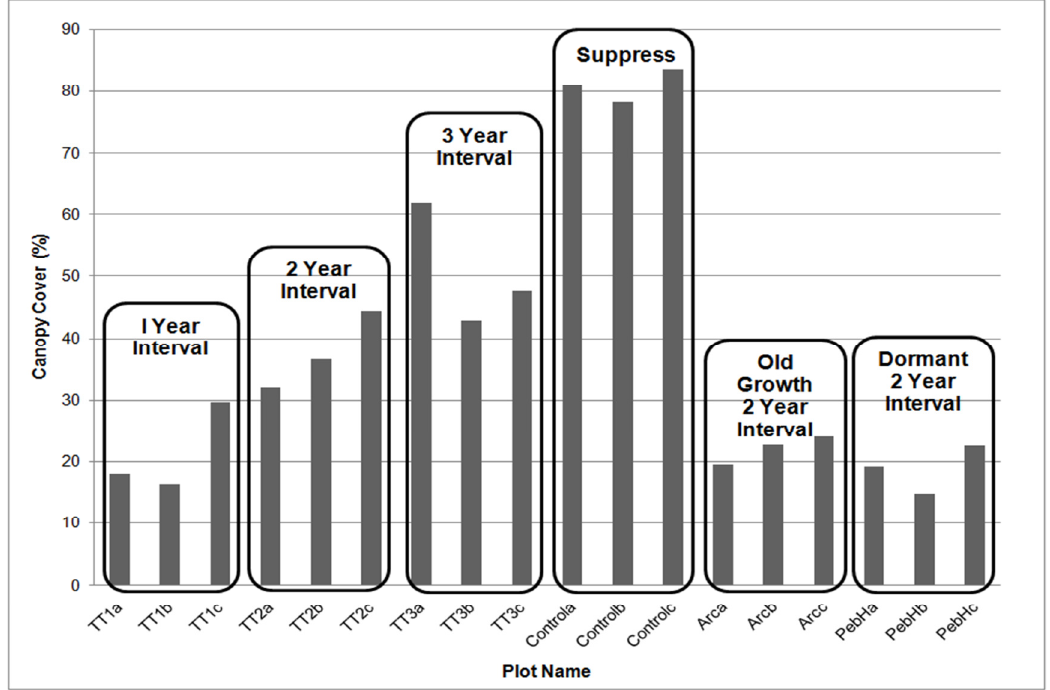
Figure 6. Portable LiDAR Derived Canopy Cover for all forest plots: 12 secondary forest with transitional varying fire return intervals (TT1, TT2, and TT3 plots), three old-growth forest plots with 2-yr fire regime (Arc plots), and three secondary forest with a dormant 2-yr fire regime (PebH